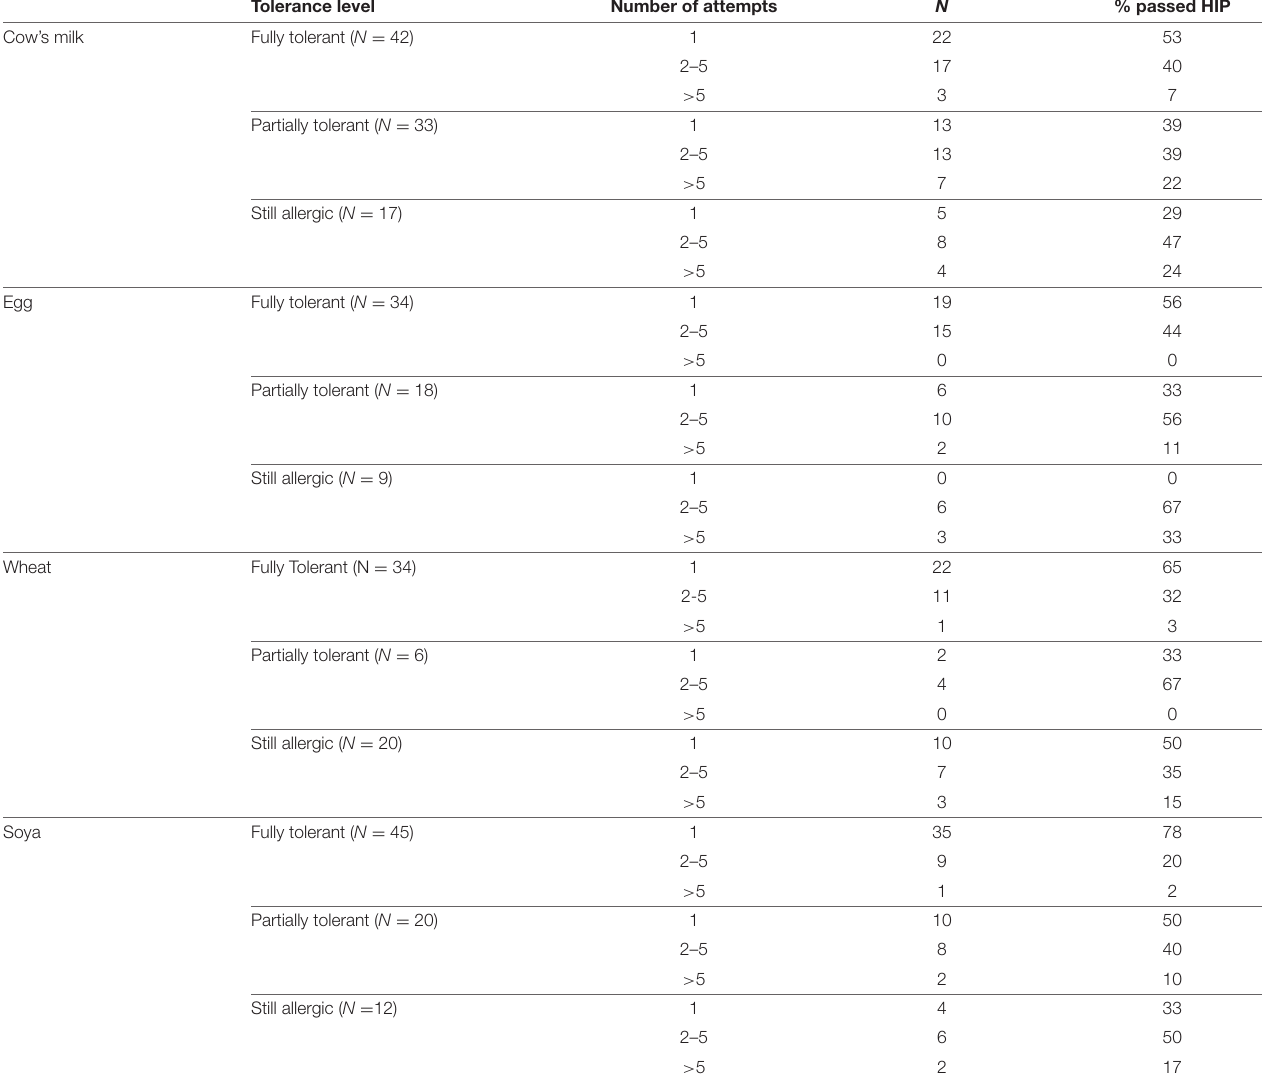
TABLE 1 | Summary of HIP attempts and attainment of outcome.